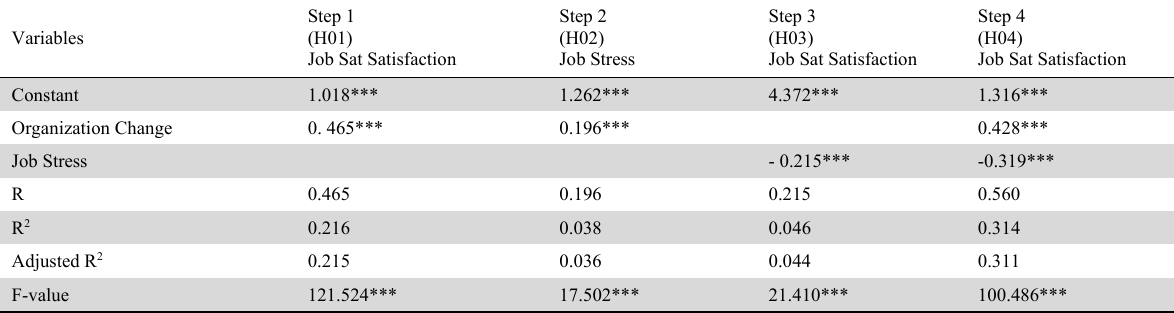
Regression analysis for the mediating effect of job stress between organizational change and job